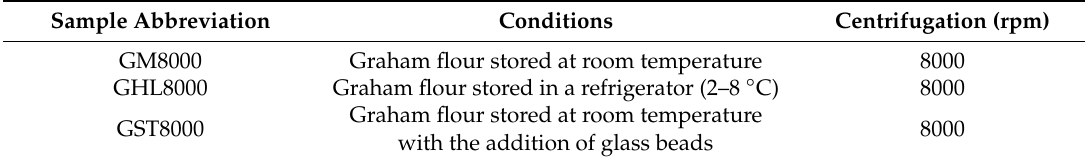
Table 2. List of conditions that were applied in the protein extraction process.